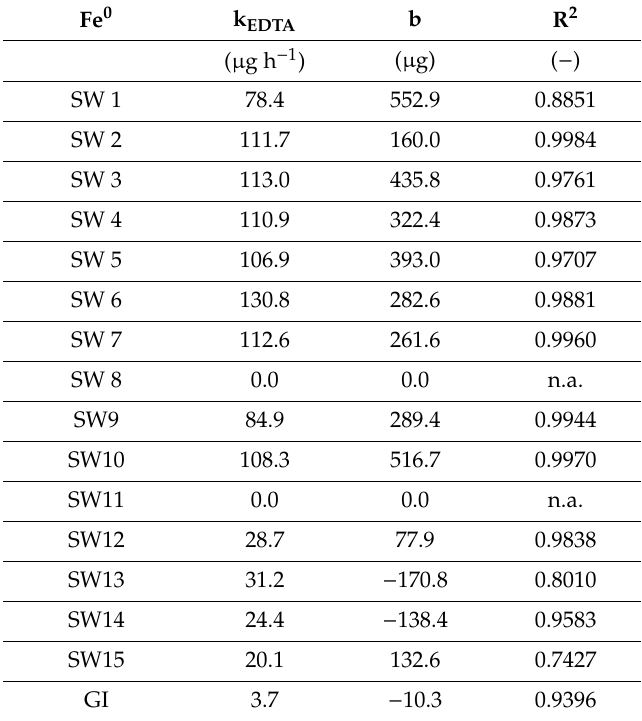
Figure 2. Time-dependent iron dissolution from (i) 0.01 g of SW1, SW5, and SW9 and (ii) 0.01 and 0.10 g of granular iron (GI). All regression parameters for 0.01 g Fe 0 are listed in Table 3. The represented lines are not fitting functions, they just join the points to facilitate visualization. Table 3. Corresponding correlation parameters (k EDTA , b, R 2 ) for SW1–SW12 and granular iron. As a rule, the more reactive a material is under given conditions, the higher the k EDTA value. R 2 is a correlation factor. General conditions: 50 mL of 2 mM EDTA solution and 0.01 g Fe 0 . K EDTA , b, and R 2 were calculated using Origin